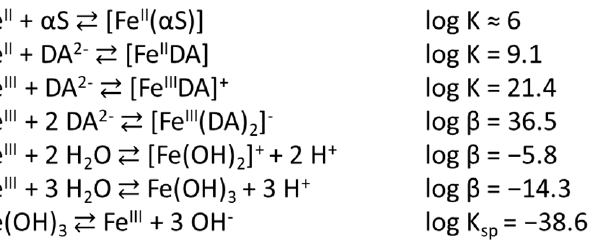
Figure 1. ( a ) Schematic representation of the putative iron coordination sphere of α S [12,13] . ( b ) Schematic representation of one of the possible [Fe(DA)(Ac- α S 119–132 )] ternary complexes, where Fe III is bound to D119, D121, and S129. Both sketches were drawn using the Avogadro and PyMol softwares [17,18] ; the peptide’s backbone was drawn as